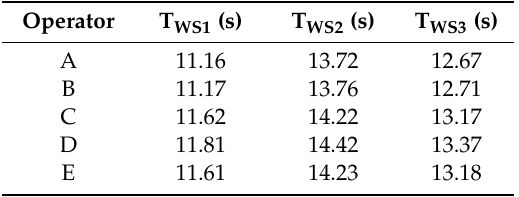
Table 9. Operating times of WSs including operator and machine times.